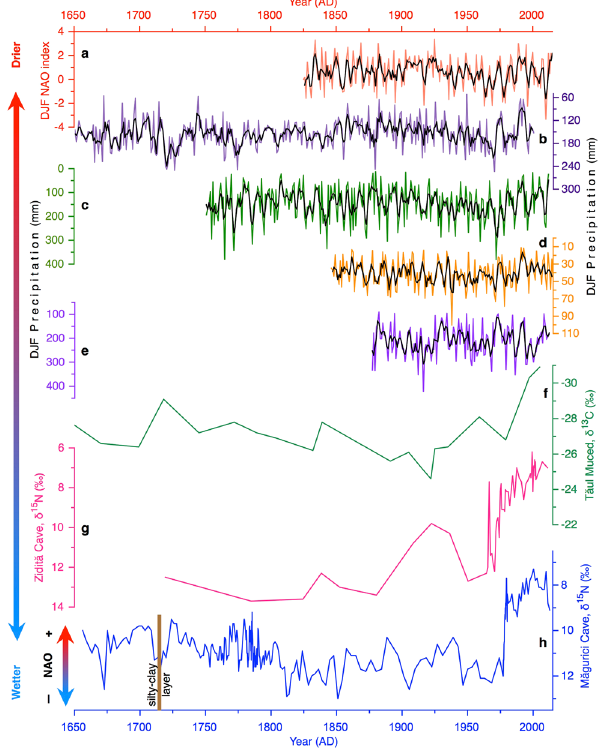
Figure 3. Comparison of guano δ 15 N with other hydroclimate proxy records between AD 1650 and 2012: ( a ) Winter (DJF) NAO index 56 ; DJF precipitation data series from ECE 12 ( b ), Marseille 45 ( c ), Budapest 45 ( d ), and Baia Mare 45 ( e ), δ 13 C of Sphagnum from Tăul Muced 46 ( f ), δ 15 N values of guano from Zidită Cave 26 ( g ), and Măgurici Cave ( h ; this study). The black smoothed lines in a–e represent the 3-year running